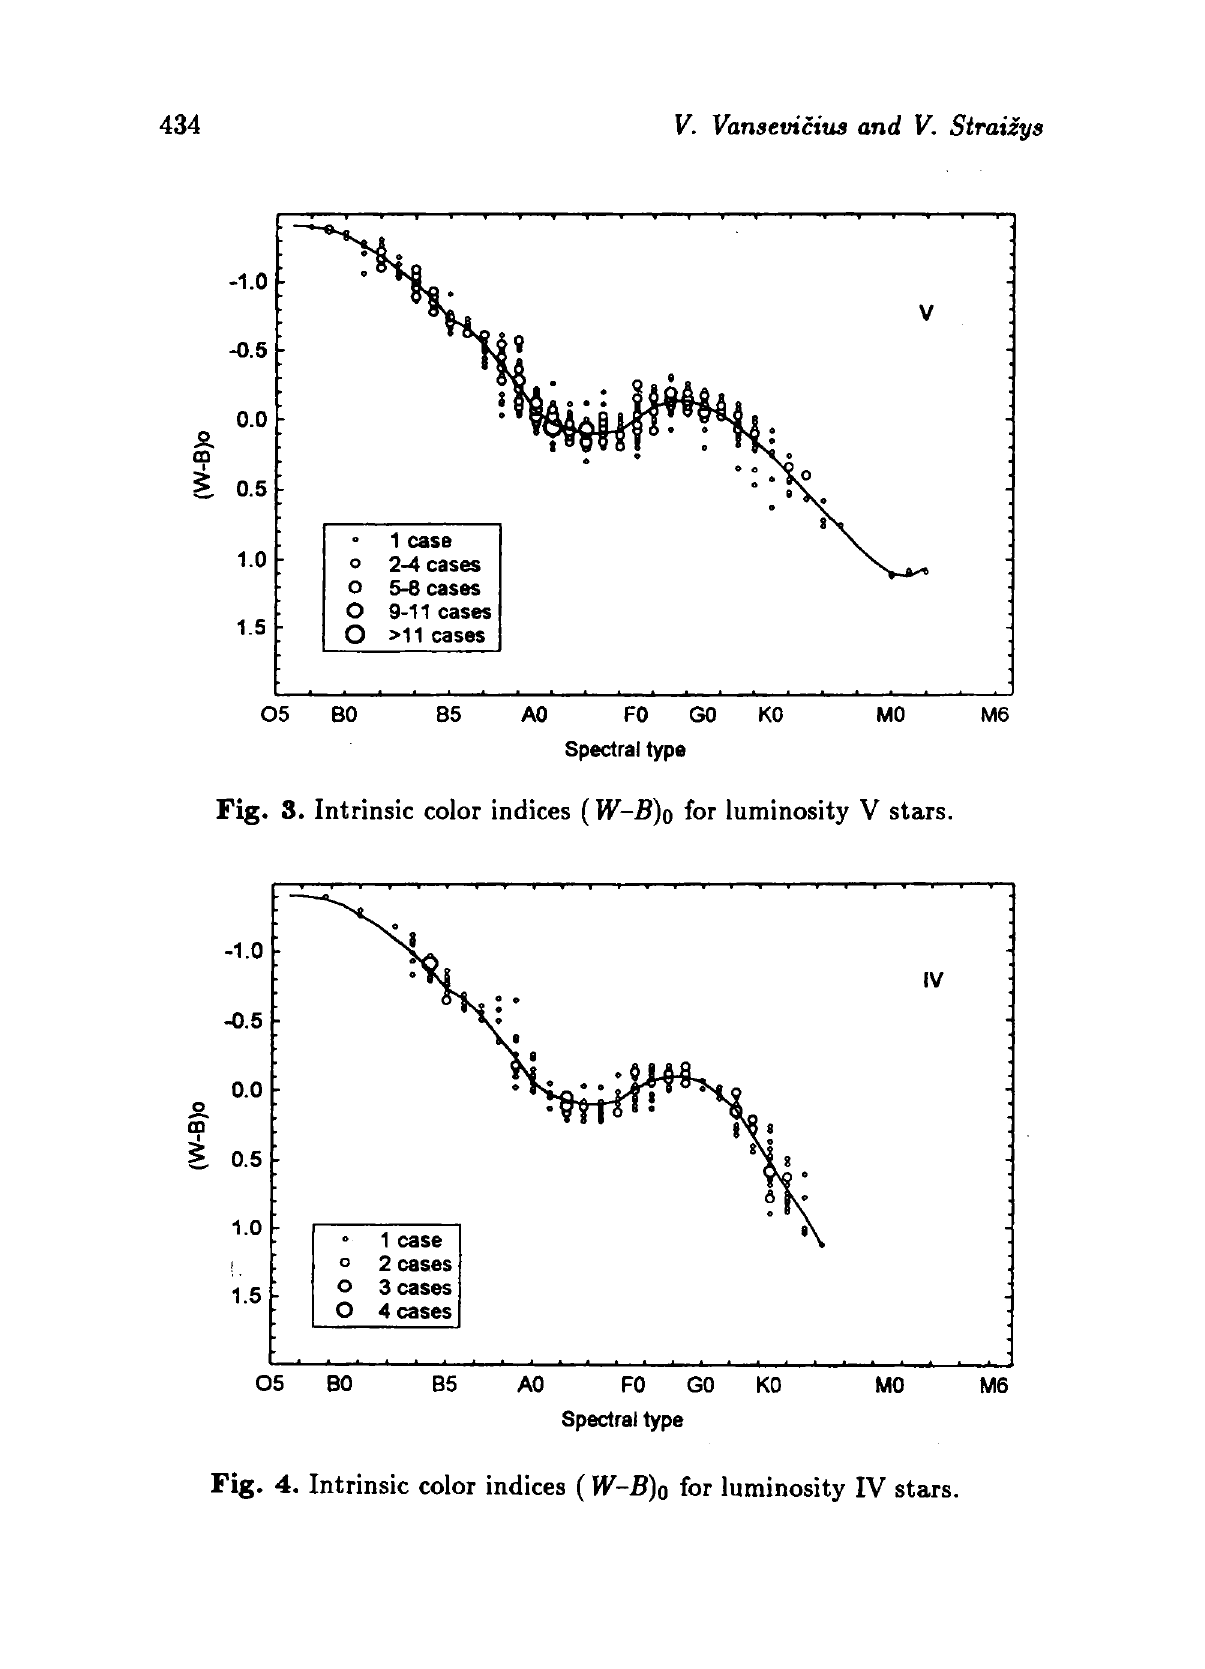
Fig. 4. Intrinsic color indices ( W-B) o for luminosity IV